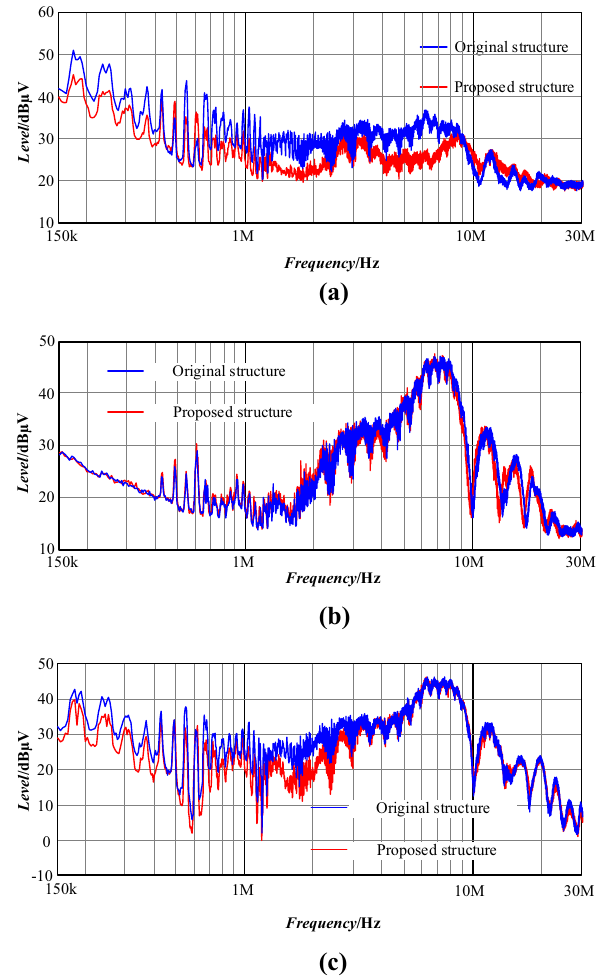
Figure 31. Noise comparison of the prototype: ( a ) DM noise; ( b ) CM noise; ( c ) total